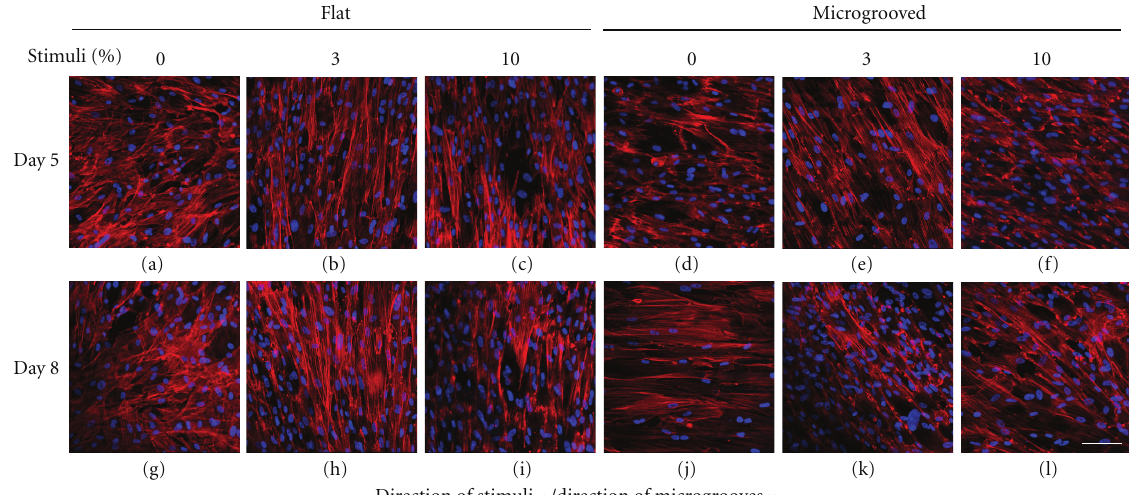
Figure 3: Actin filaments of MSCs. On the flat surface, unstrained MSCs were randomly oriented (a) and strained MSCs were oriented perpendicular to the direction of grooves regardless of the magnitude of stimuli ((b), (c)). On the microgrooved surface, MSCs were oriented along the microgrooves without stimuli (d). Immediately following mechanical strain, MSCs were aligned away from the microgrooves ((e), (f)). The tendency of each group was maintained until 3 days after stimuli stopped ((g)–(l)). (All photographs were taken at the same magnification level; scale bar = 100 μ